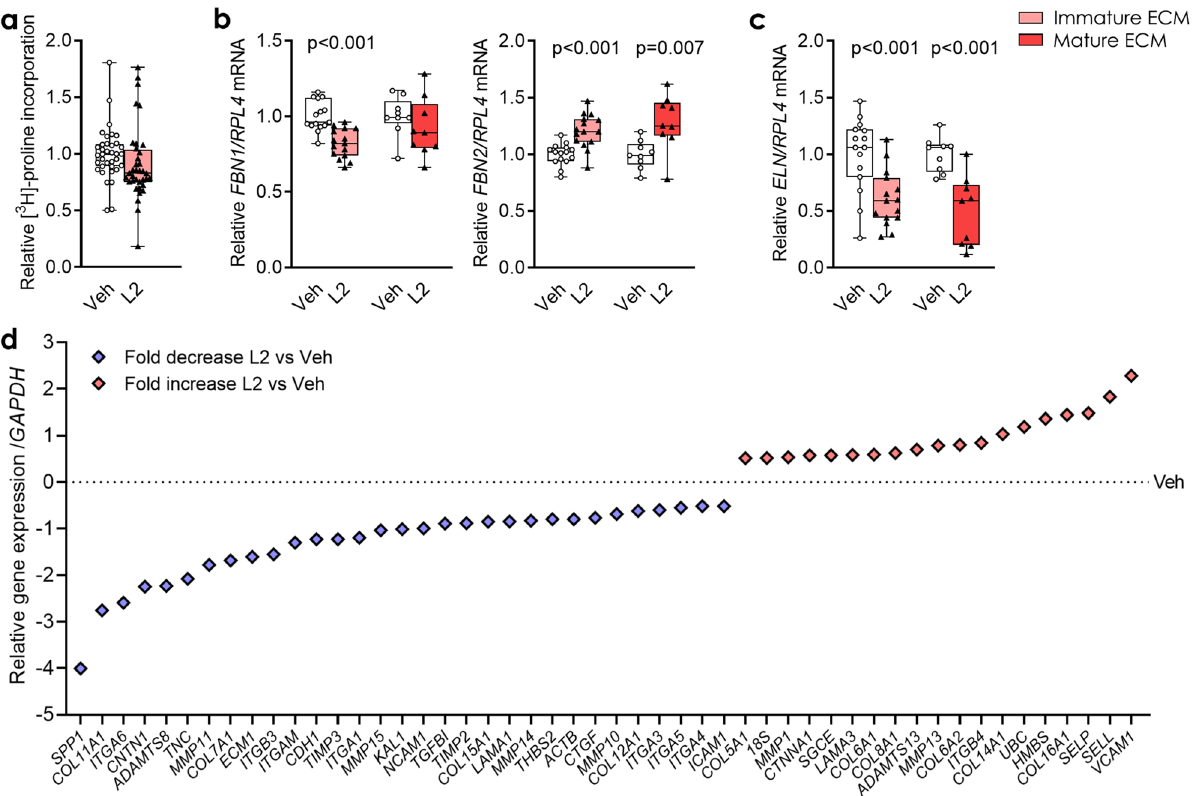
Figure 3. ADAMTSL2 alters expression of ECM and ECM-associated genes in human cardiac fibroblasts. Human foetal cardiac fibroblasts were cultured for four or seven days (see Supplementary Fig. S3a), forming an immature or mature extracellular matrix (ECM), and transduced with ADAMTSL2 (L2) or vehicle control (Veh) adenoviruses on day one or four, respectively. Data represent experiments from three different cell passages. ( a ) Incorporation of [ 3 H]-proline representing total collagen synthesis in L2 vs. Veh (n = 36). ( b , c ) FBN1 , FBN2 and ELN mRNA levels in L2 vs. Veh (n = 9–15). Gene expression was normalized to RPL4 ( b , c ). Data are presented as mean ± min/max values and statistical analysis was performed using the Student t -test vs. respective controls. ( d ) Gene expression array of 84 ECM and adhesion molecule genes showing 50 differentially expressed genes, ± 0.5-fold in L2 vs. Veh (pools of n = 3–6). Gene expression was normalized to GAPDH and Veh and presented as –ΔΔCT